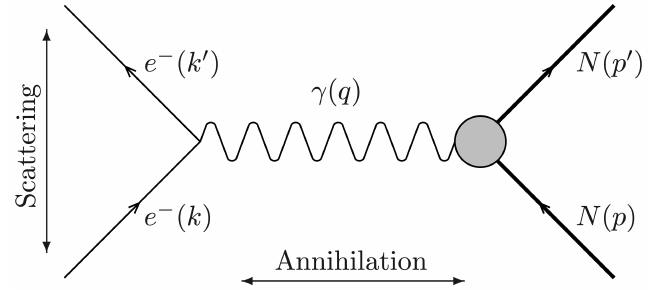
Figure 1: Feynman diagram for scattering and annihilation.